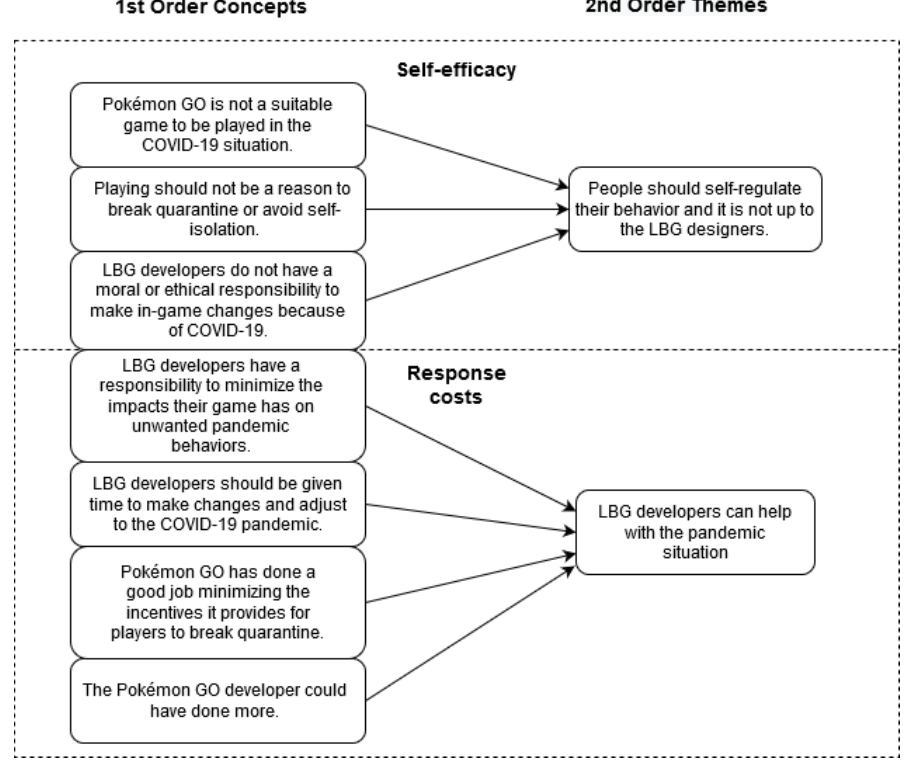
Figure 3. The main themes of the social media analysis grouped into second order